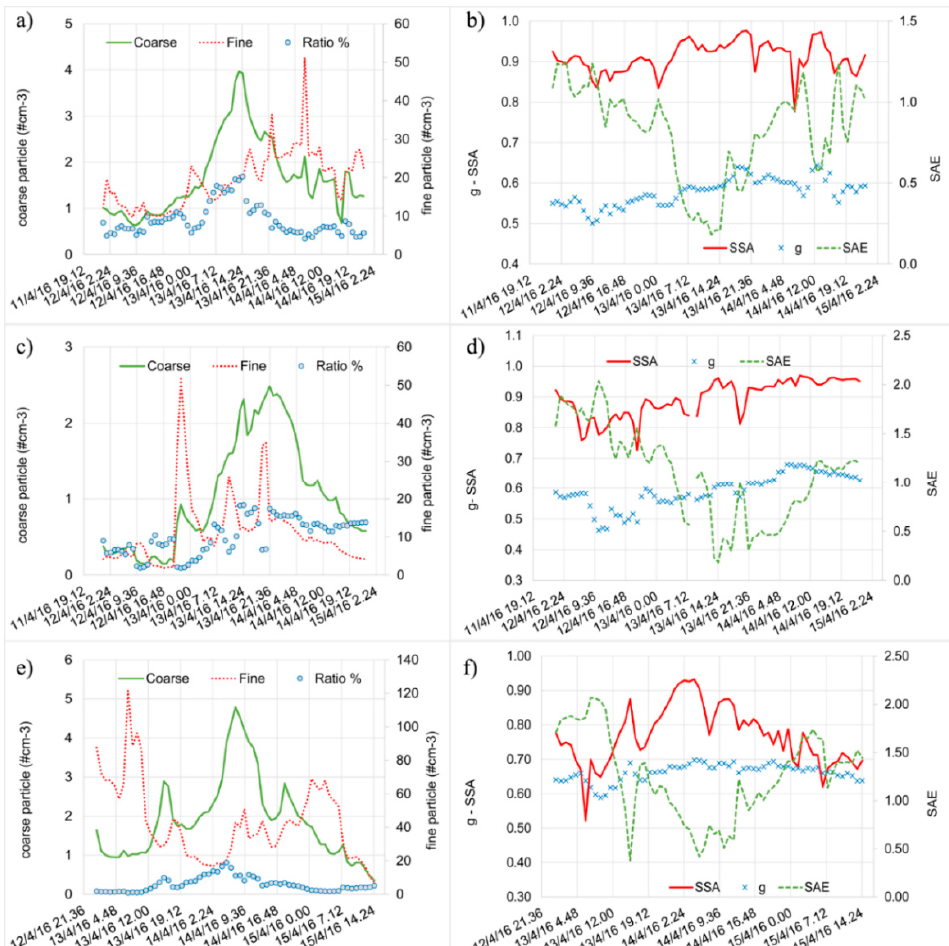
Figure 6. Time evolution of fine and coarse mode (aerosol size distribution) for the period 12th–14th April for ( a ) CGR, ( c ) LMT, and ( e ) ECO observatories, respectively, during the Saharan dust event. Time evolution of SAE, SSA, and g for the dust event at ( b ) CGR, ( d ) LMT and ( f ) ECO observatories, respectively.